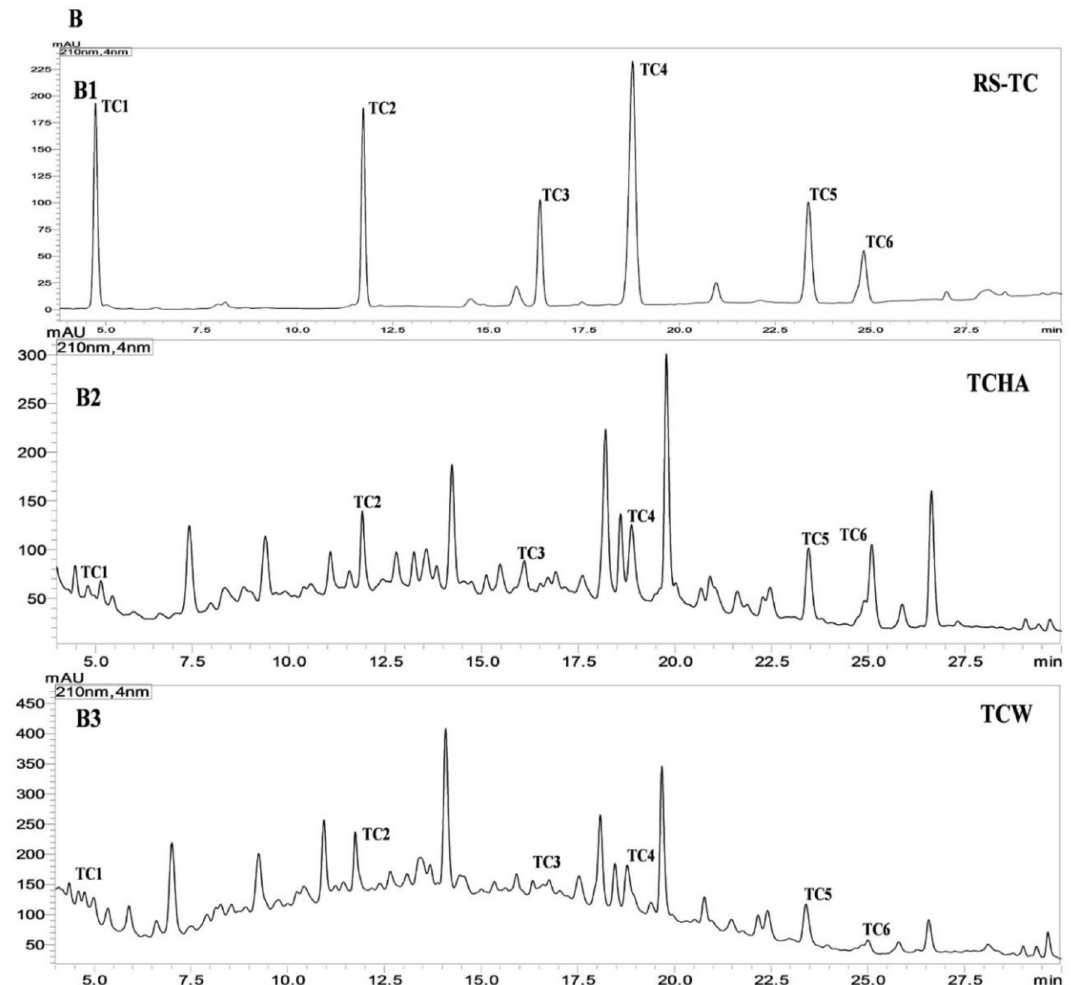
Fig 2. UHPLC − PDA chromatogram of reference compounds (RS) and samples with detection for ( B ) Tinospora cordifolia at 210 nm for TC (1–6) in the ( B1 ) reference compounds ( B2 ) TCHA ( B3 ) TCW where cordifolioside-A ( TC1 ), 20- β -hydroxy ecdysone ( TC2 ), tinosporaside ( TC3 ), 8-hydroxy tinosporide ( TC4 ), tinosporide ( TC5 ), columbin ( TC6 ).